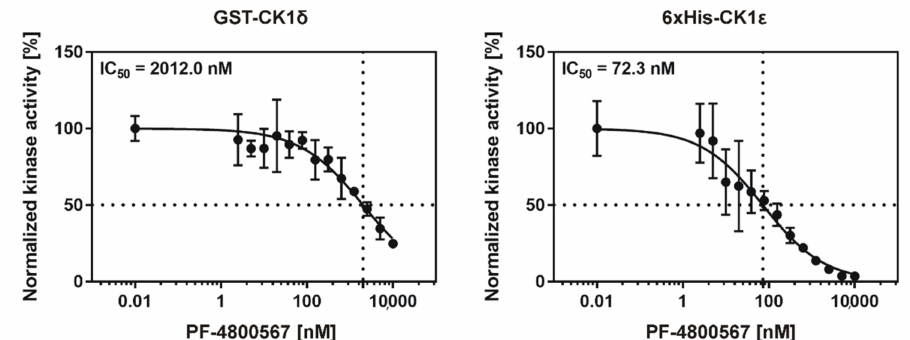
Figure 10. IC 50 values of inhibitor PF-4800567 for GST-CK1 δ and 6 × His-CK1 ε . In vitro kinase reactions were performed in presence of increasing concentrations (1 to 250 nM) of the CK1 ε -specific inhibitor PF-4800567 using GST-CK1 δ (7 nM) or 6 × His-CK1 ε (70 nM) as kinases. Kinase activity